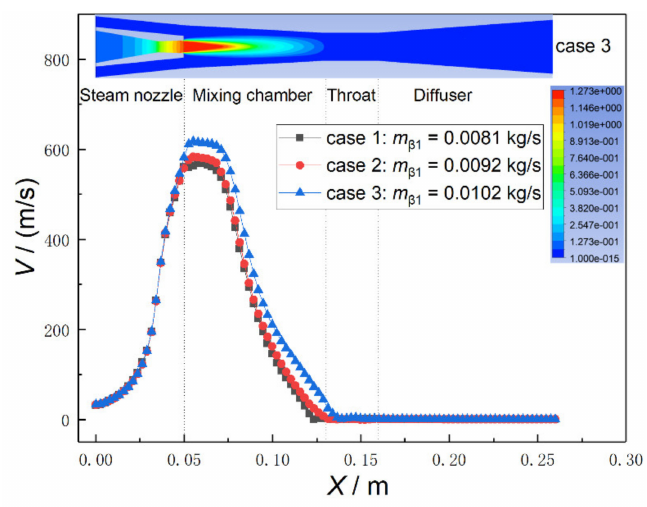
Figure 8. Contours of Mach number in axial section for case 3 and axial profiles of steam velocities at different steam inlet mass flow rates.